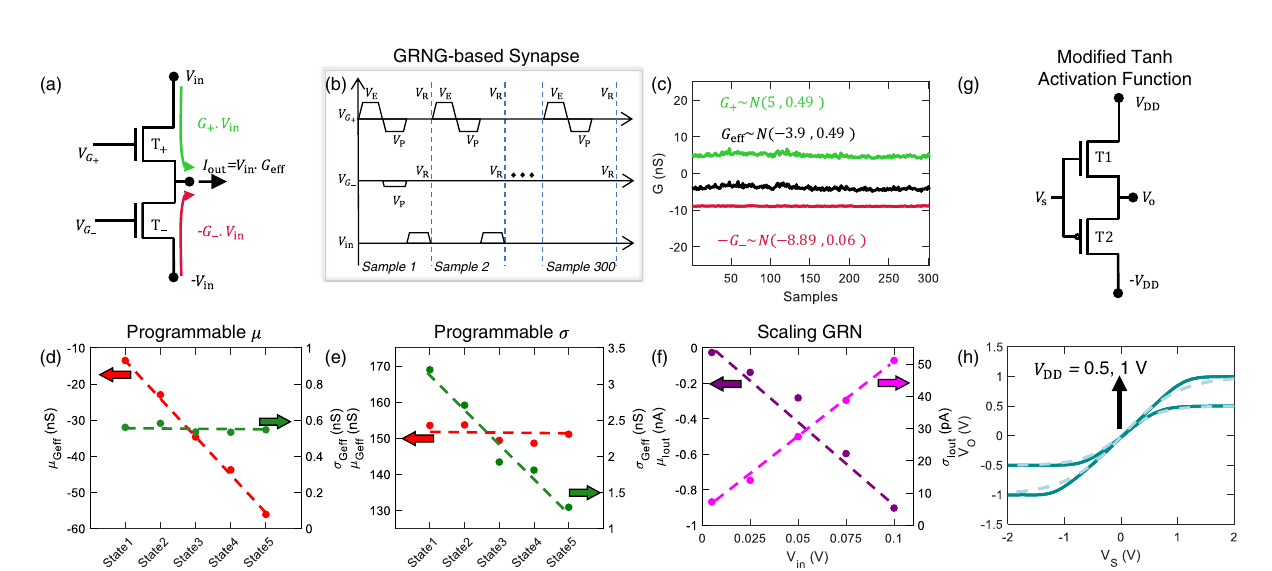
Fig.4|GRNG-basedsynapseandmodi fi edtanhactivationfunction.a Schematic oftheGRNG-basedsynapse.Theinputtothesynapse, V in isappliedas+ V in and- V in to the memtransistors, T + and T (cid:2) with conductance G + and G (cid:2) (modulated using V G and V G ), respectively. The effective conductance of this synapse is given by (cid:2) + G G (cid:2) G (cid:2) , allowing positive and negative conductance. b Waveform applied eff = + to the synapse to generateGRNs withindependent controlover μ and σ . c G + , - G (cid:2) and G eff ofthesynapsesampled300times,whereT + controls σ andT (cid:2) controls μ : GRNG-based synapse showing d independent control of μ G